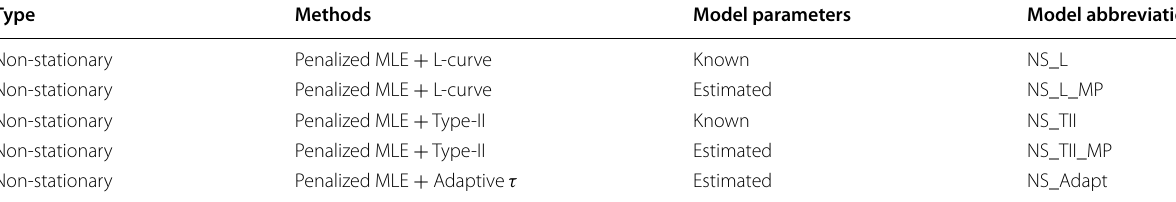
Table 1 List of different types of models considered in the current study